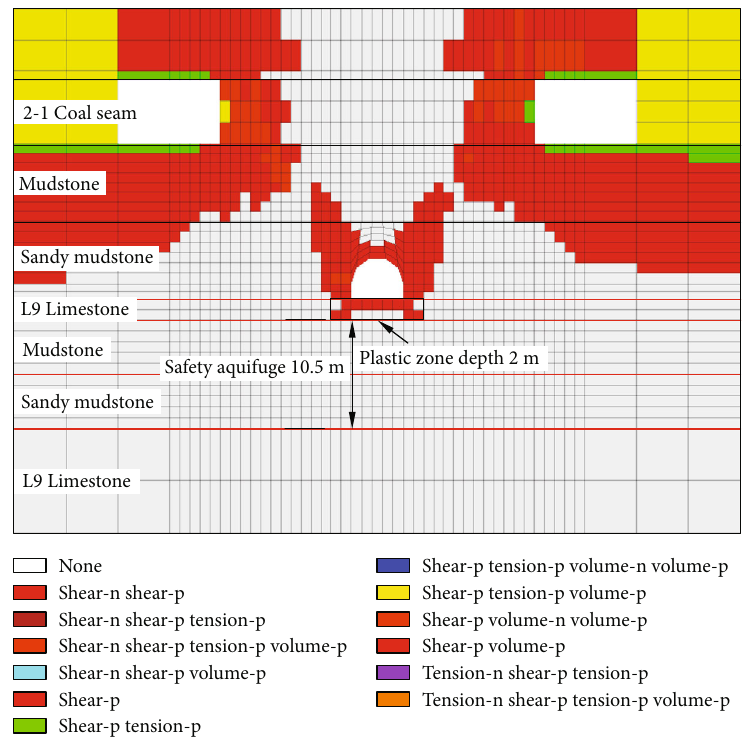
Figure 10: Failure of bottom rock stratum at y = 260 m in the fl oor drainage roadway at an external of